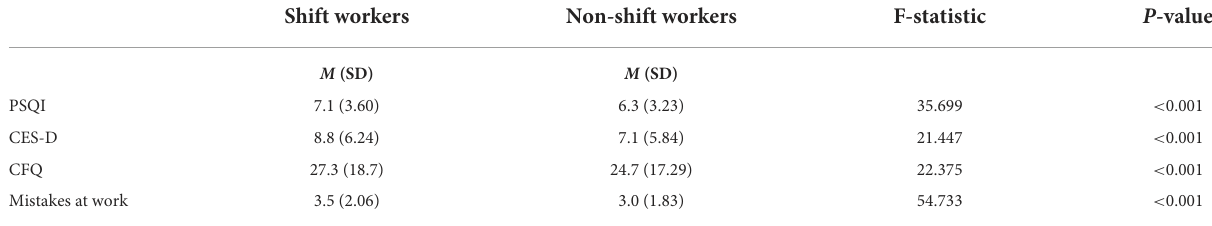
TABLE 2 Clinical characteristics of shift and non-shift workers. Shift workers Non-shift workers